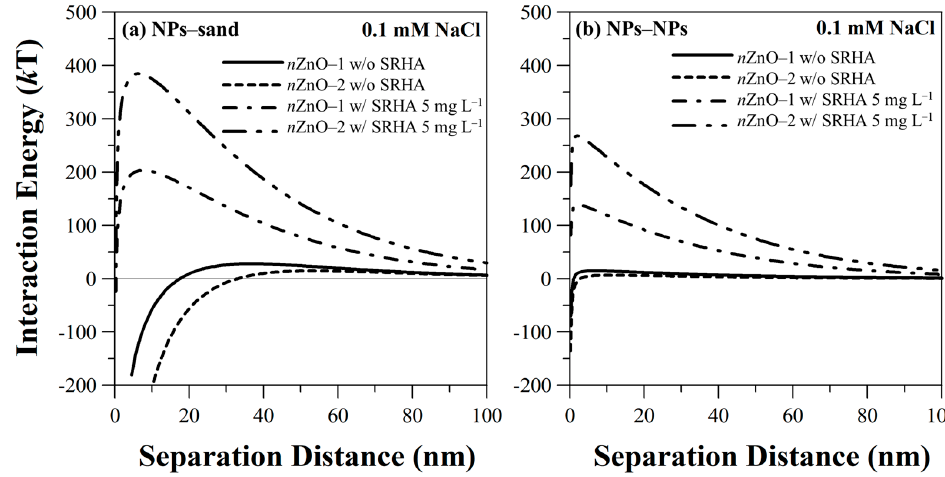
Figure 5. DLVO interaction forces of two types of n ZnO for quartz sand surfaces–nanoparticle ( a ) and nanoparticle–nanoparticle ( b ) and in NaCl solution (0.1 mM).